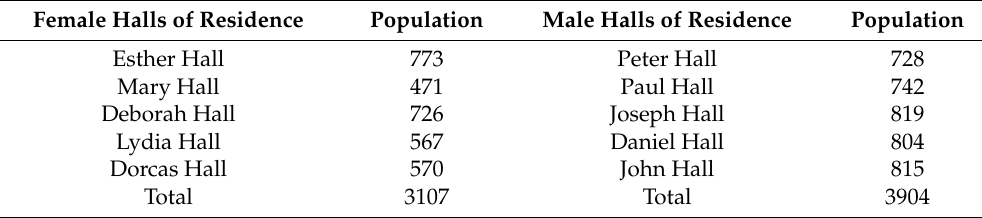
Table 3. Covenant University student population as at